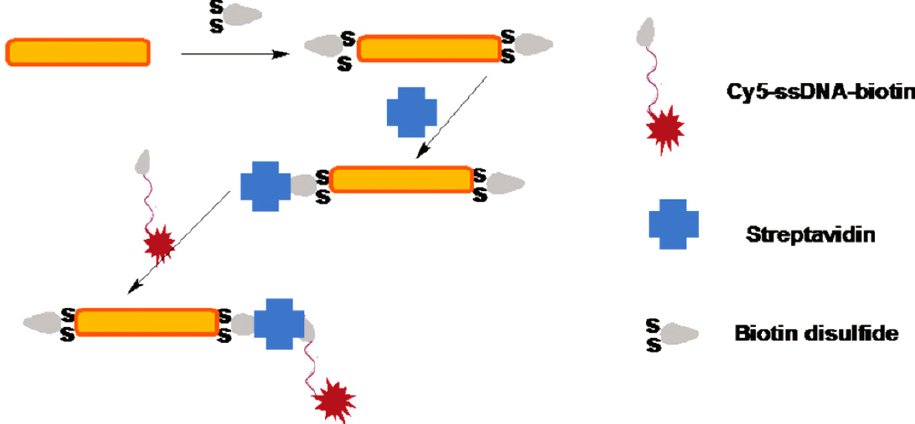
Figure 33. Combination of gold nanorods with CTAB and Cy5 ssDNA [127].